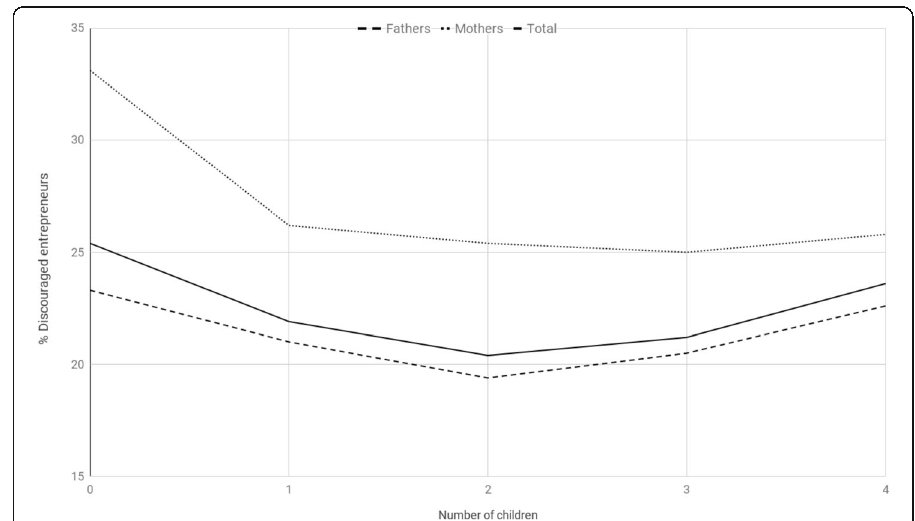
Fig. 2 Number of children and exit from business ownership